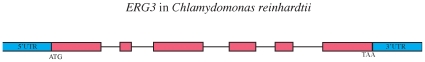
Schematic diagram of sterol C-5 desaturase in C. reinhardtii as annotated in the JGI Chlamydomonas Genome Version 4.0.ERG3 has six exons and five introns.